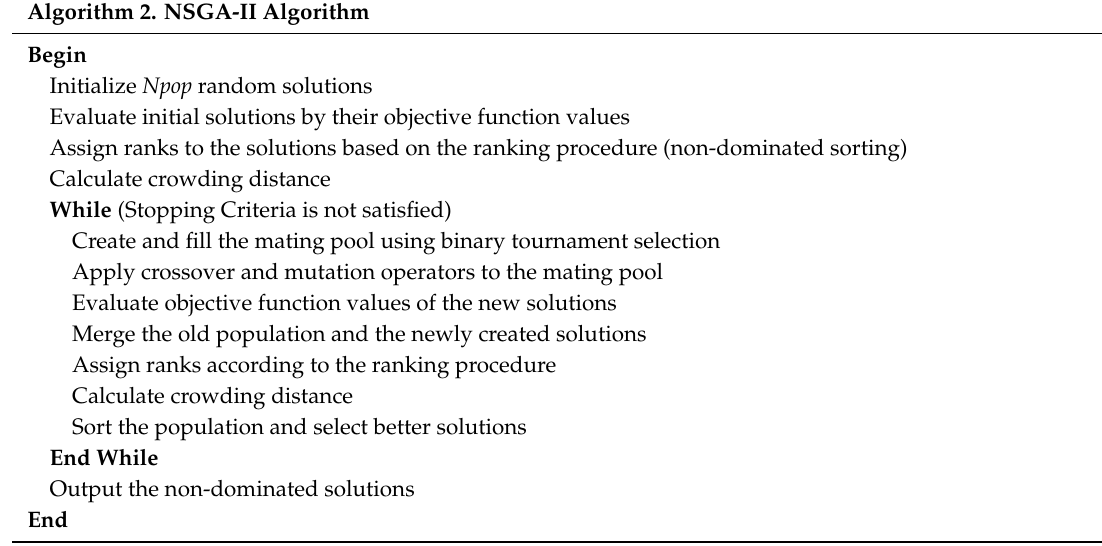
Algorithm 2. NSGA-II